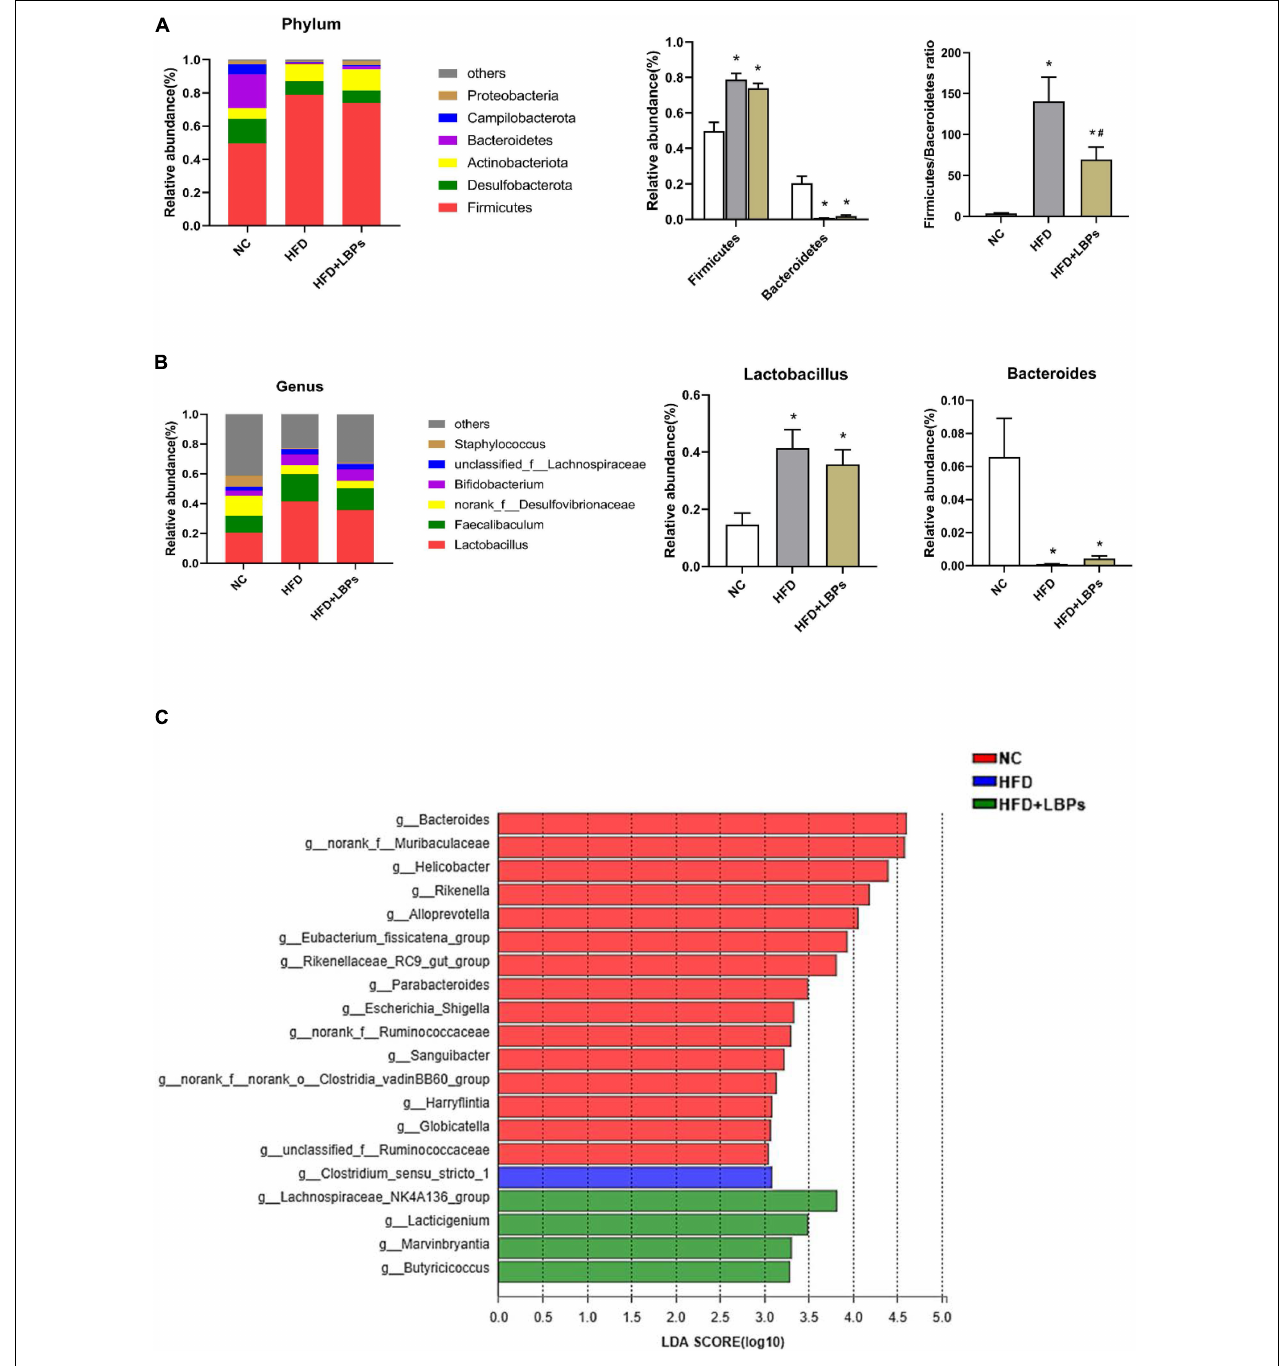
FIGURE 6 | Effects of Lycium barbarum polysaccharides (LBPs) on composition of gut microbiota. (A) Composition of gut microbiota at phylum level and differences in relative abundance of Firmicutes and Bacteroidetes at phylum level. (B) Composition of gut microbiota at genus level and differences in relative abundance of Lactobacillus , and Bacteroides . LDA score plot with LDA scores (log 10) higher than 3 (C) . * P < 0.05 vs. NC group and # P < 0.05 vs. HFD